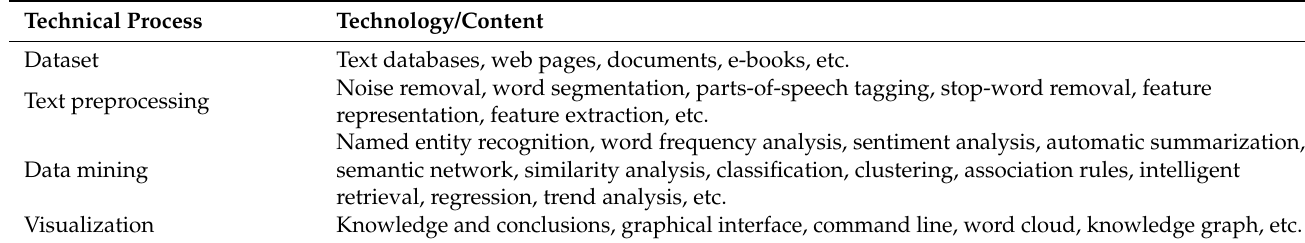
Table 1. Key technical processes and content of text